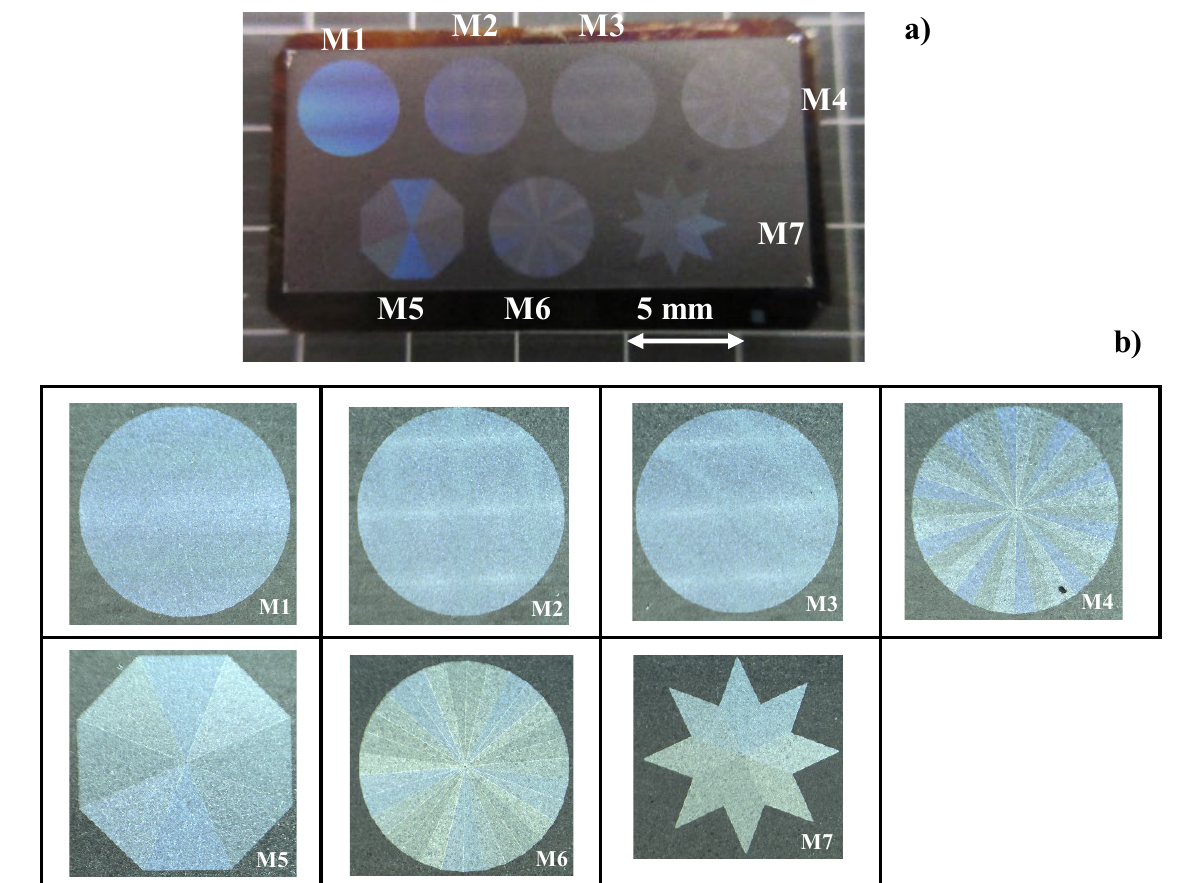
Figure 8. Seven emblems, laser-printed onto the nitrided flat SKD11 punch. ( a ) Overall view of punch surface, and ( b ) optical-microscopy images of seven emblems.